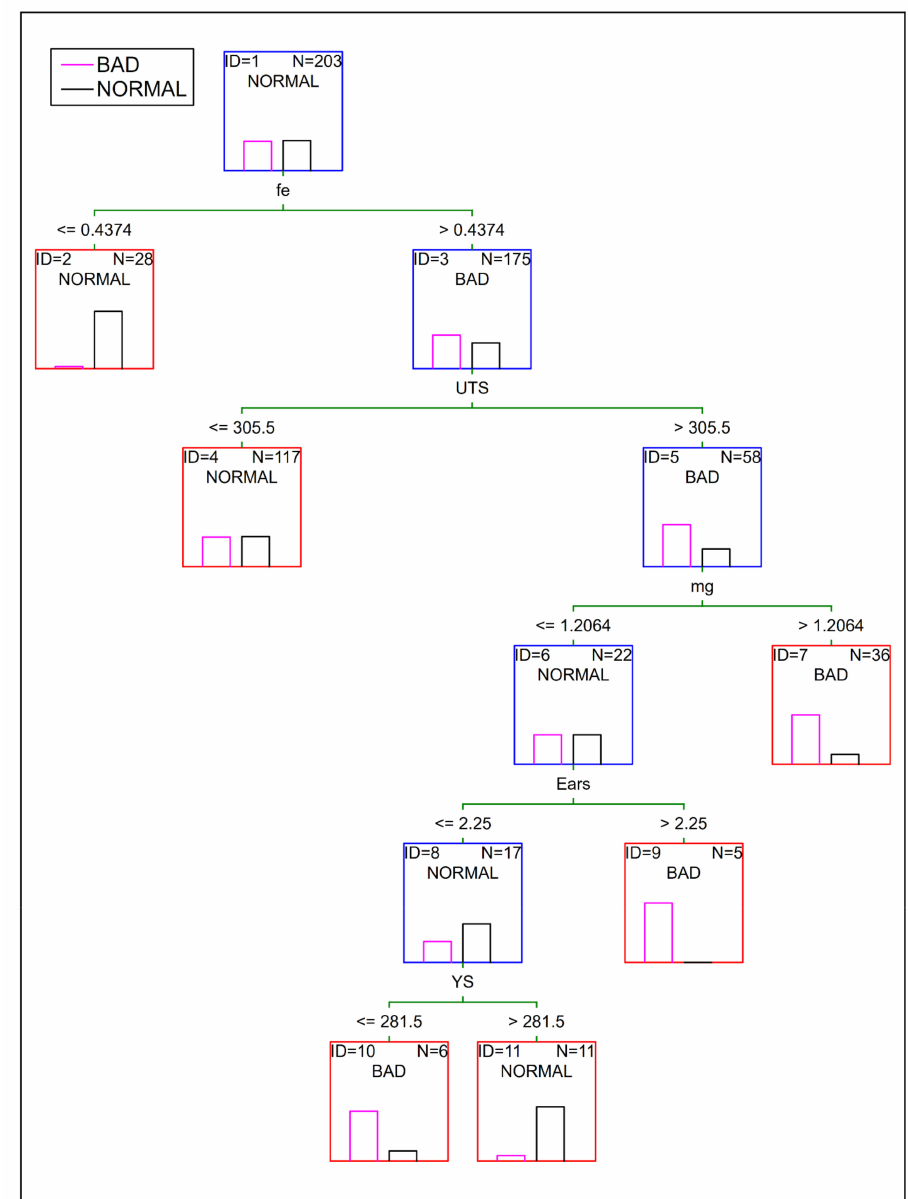
Figure 10. Interactive classification tree for the amount of short cans (2Q), C&RT